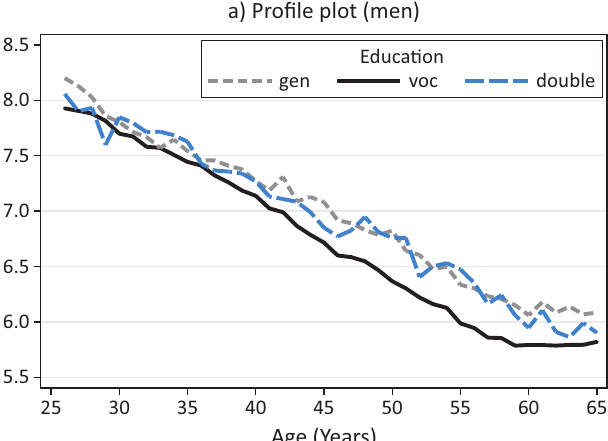
Figure A6. Health satisfaction over the life course: General versus vocational and double qualifications (men). Notes: Con- ditional profile plot estimated by non-parametric models of vocational and general training on health satisfaction. Control variables include period effects, cohort effects, German nationality, parental educational background, residence in West Germany, and educational level. Detailed regression results available upon request. Data source: GSOEP (n.d.).